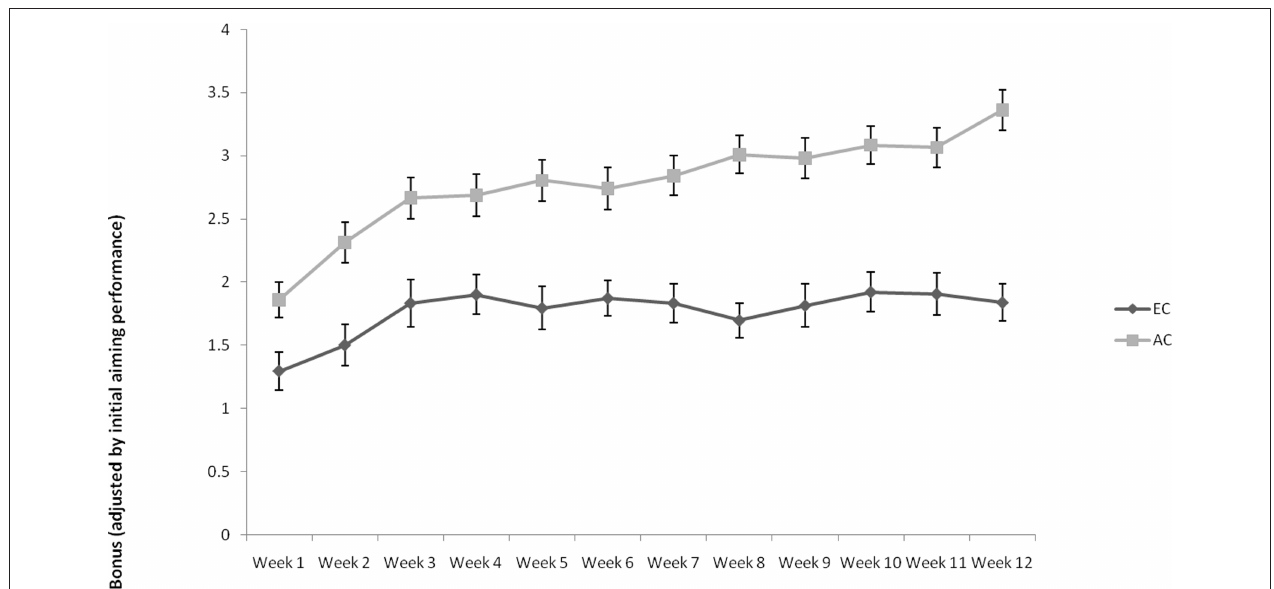
FiGurE 5 | bonus Taken as a function of training instructions (EC vs. Standard), adjusted by subject-specific aiming